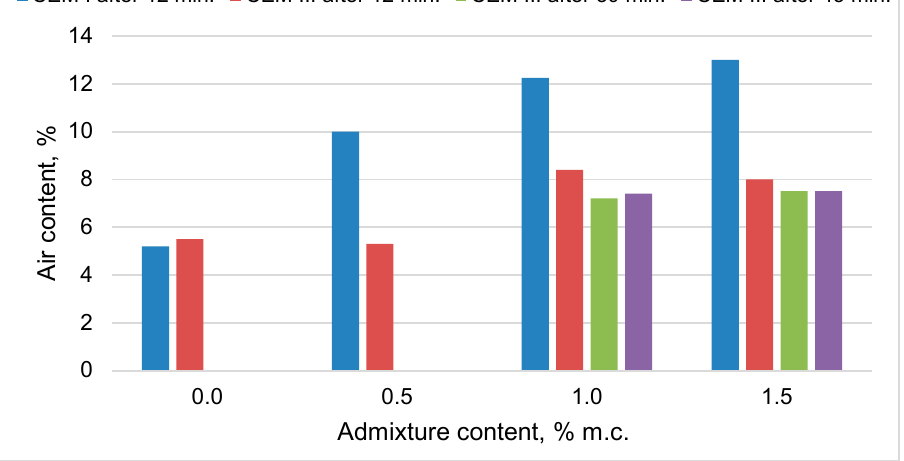
Figure 1. Comparison of test results for the air content in the mixture depending on the cement used and the content of admixture containing aluminum powder.